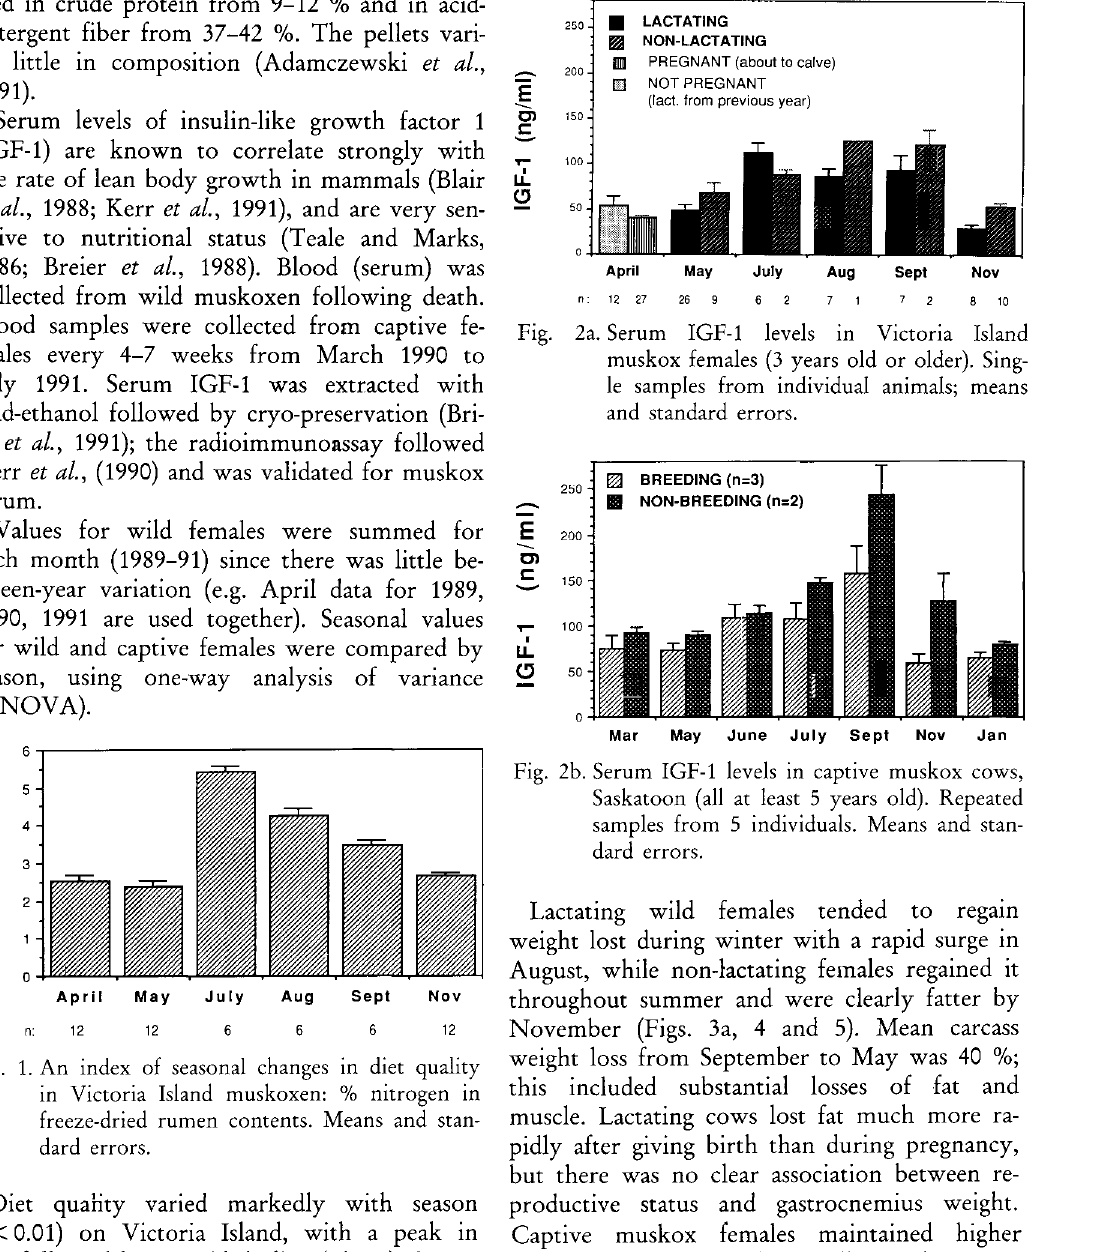
Fig. 1. An index of seasonal changes in diet quality in Victoria Island muskoxen: % nitrogen in freeze-dried rumen contents. Means and stan dard errors.